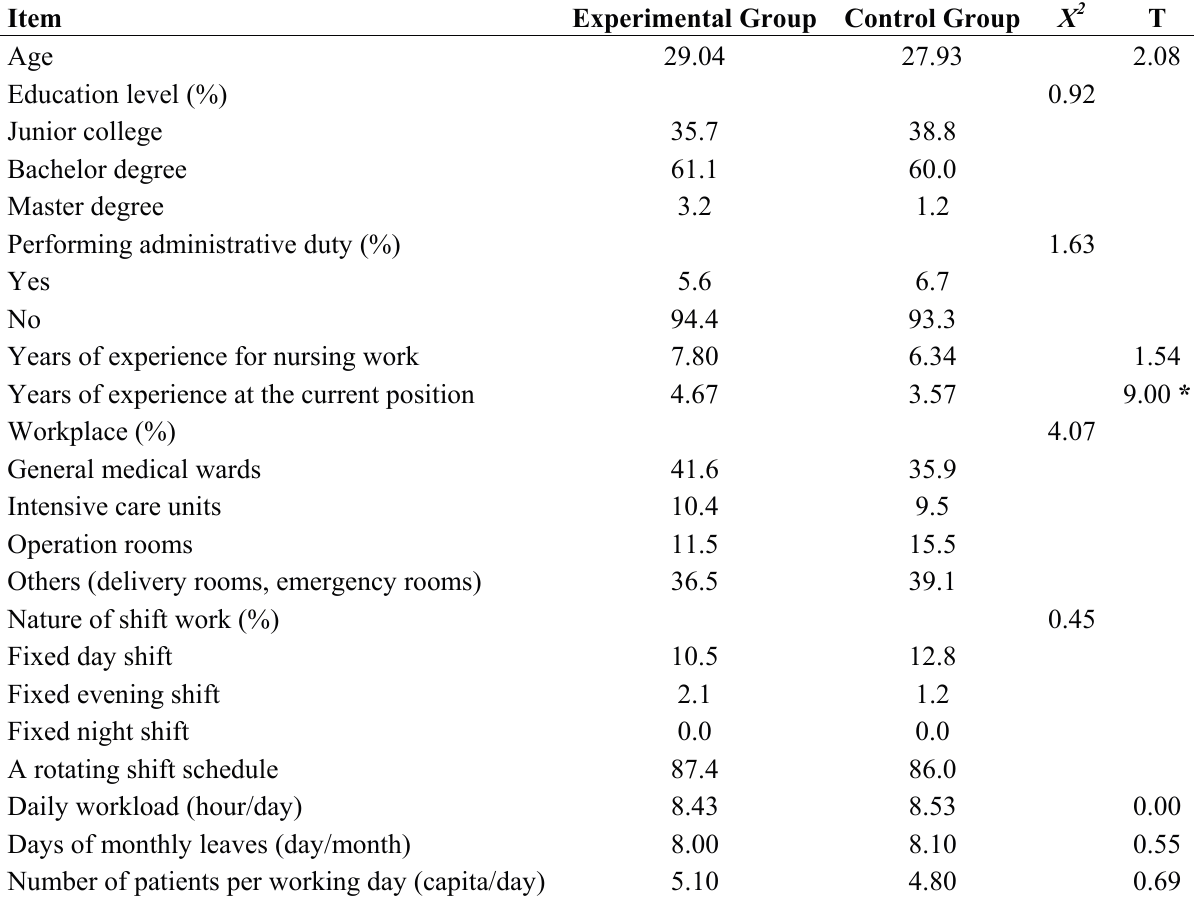
Table 2. Basic information of the